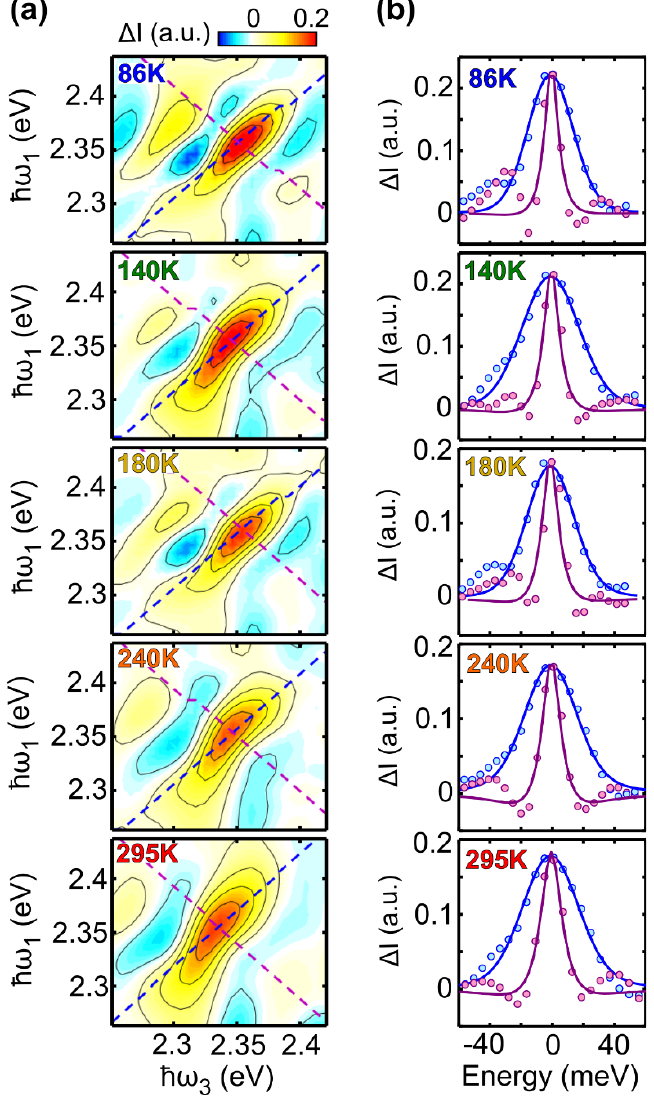
Figure 3. Temperature dependent linewidth analysis: ( a ) purely absorptive 2DES maps around the absorption peak at 2.34 eV at population time close to zero and at temperatures 86 K (t 2 = 5 fs), 140 K (t 2 = 10 fs), 180 K (t 2 = 5 fs), 240 K (t 2 = 5 fs) and 295 K (t 2 = 10 fs); dashed lines represent data points that better approximate the diagonal and antidiagonal lines, not always straight due to different energy resolution along excitation and detection axes. ( b ) Best fit results (solid lines) and experimental data (colored dots) of the diagonal (blue curve) and anti-diagonal (violet curve) linewidth at each temperature and population time reported in panel ( a